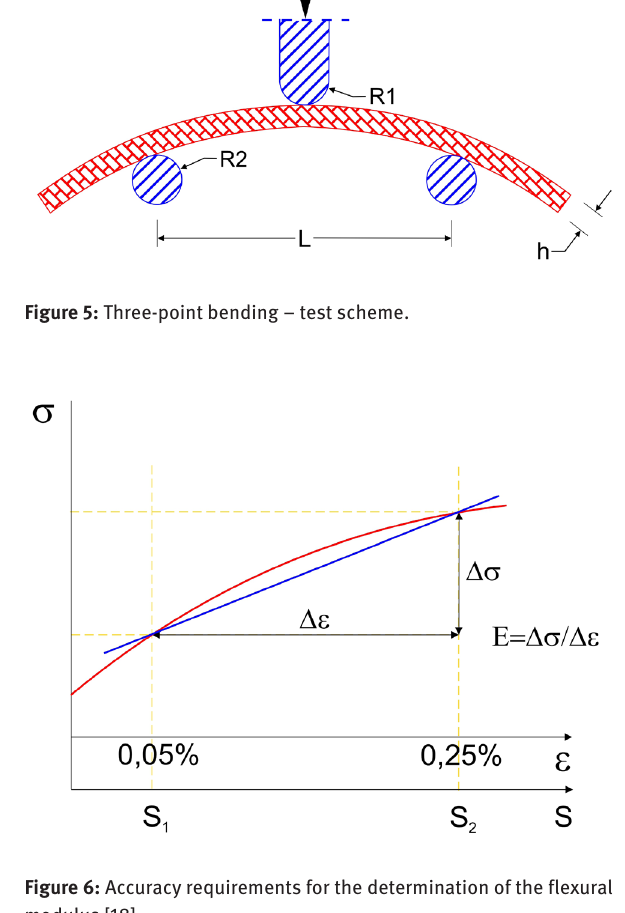
Figure 6: Accuracy requirements for the determination of the flexural modulus [18].